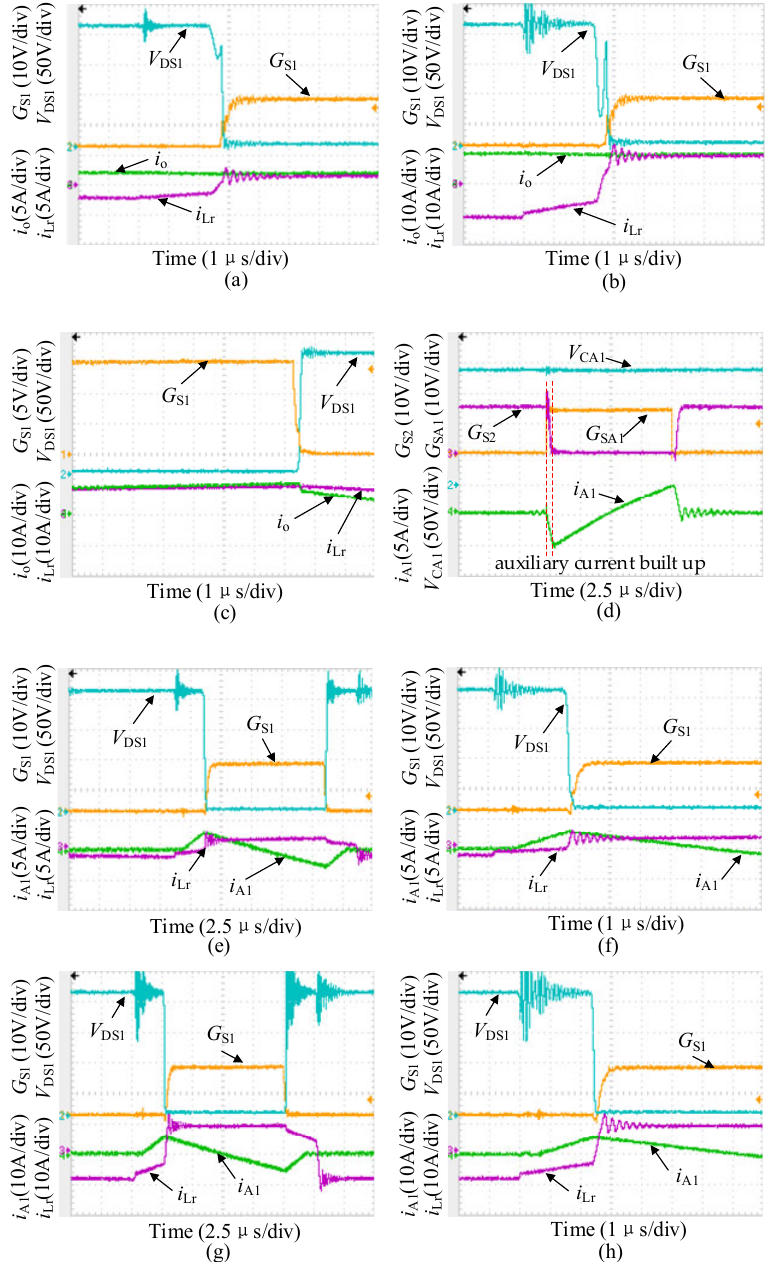
Figure 9. Main experimental waveforms of the ITLDC: ( a ) turn on process of S 1 without ACACs, I o = 2 A, ( b ) turn on process of S 1 without ACACs, I o = 10 A, ( c ) turn ‐ off process of S 1 , ( d ) auxiliary current build ‐ up process, ( e , f ) switching process of S 1 with ACACs, I o = 2 A, ( g , h ) switching process of S 1 with ACACs, I o = 10 A.